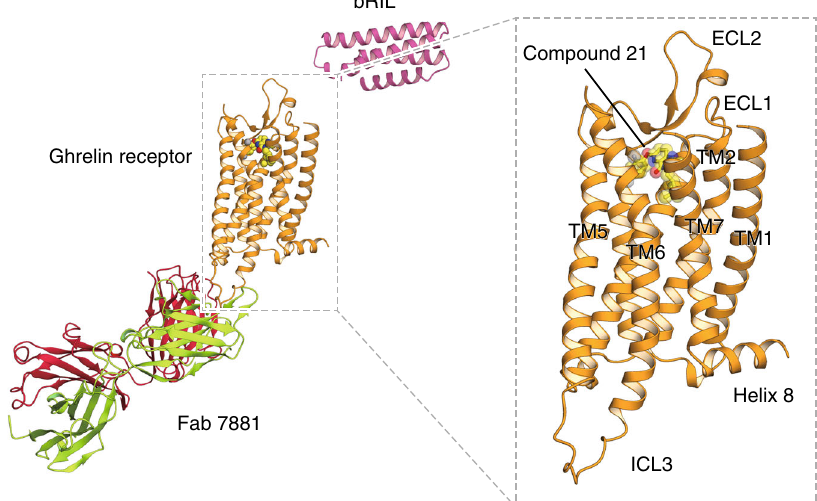
Fig. 1 Structure of the antagonist-bound human ghrelin receptor. Overall structure of the bRIL – hGHSR – Fab 7881 – Compound 21 complex. The ghrelin receptor is shown in cartoon representation and colored in orange. The bRIL fusion protein is shown in pink cartoon representation. For Fab 7881, the crimson and green-yellow cartoons represent the heavy and light chains, respectively. Compound 21 is shown as spheres and sticks with carbon atoms in yellow, oxygen in red, and nitrogen in